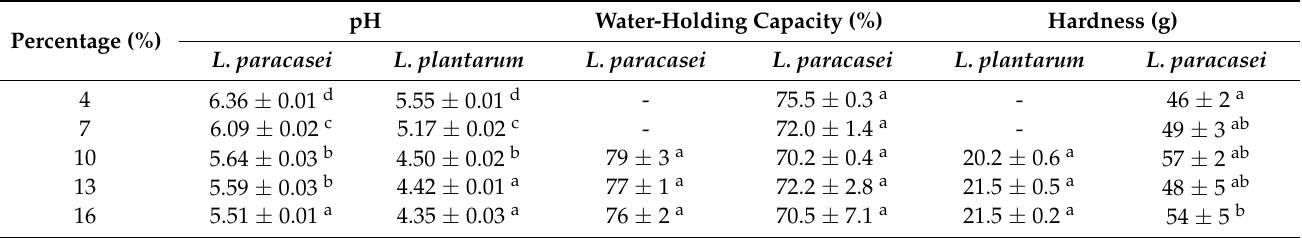
Table 2. Effect of different percentages of L. paracasei —and L. plantarum —fermented coagulant on the properties of tofu